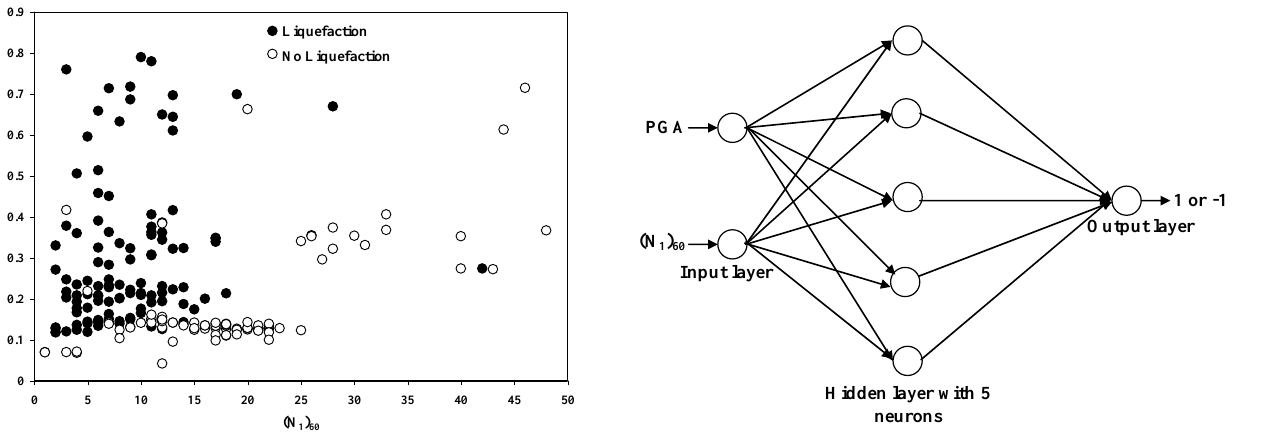
Figure 6 ANN architecture for MODEL II. Fig. 6. ANN architecture for MODEL II.